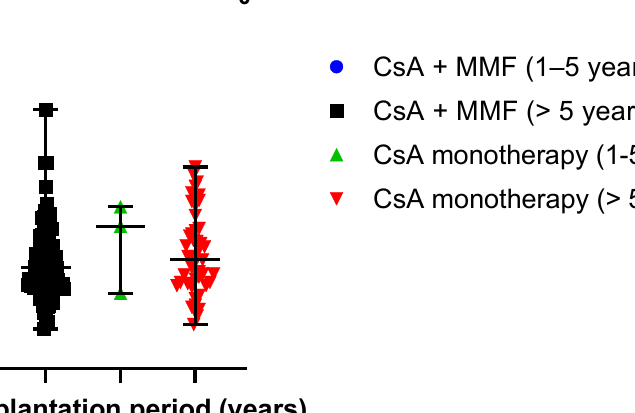
Figure 6. Distribution of CsA C 0 values in the study groups: CsA + MMF and CsA monotherapy; MMF—mycophenolate mofetil; CsA—cyclosporine. Scatter plots display the individual C 0 values’ distribution from the median in CsA-receiving study groups (median ± SE): 120.00 ± 7.26 µ g / L (CsA + MMF, post-transplantation time: 1–5 years) versus 132.00 ± 24.23 µ g / L (CsA monotherapy, post-transplantation time: 1–5 years); 94.00 ± 3.39 µ g / L (CsA + MMF, post-transplantation time > 5 years) versus 101.50 ± 5.51 µ g / L (CsA monotherapy, post-transplantation time > 5 years). Respectively, the mean values(mean ± SD)wereasfollows:128.55 ± 51.84 µ g / L(Tacro + MMF,post-transplantationtime: 1–5years) versus 117.33 ± 41.97 µ g / L (Tacro monotherapy, post-transplantation time: 1–5 years); 97.90 ± 33.23 µ g / L (Tacro + MMF, post-transplantation time > 5 years) versus 106.54 ± 37.39 µ g h / L (Tacro monotherapy, post-transplantation time > 5